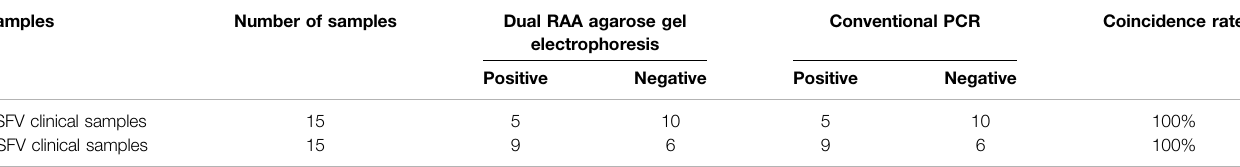
TABLE 6 | Comparison of Dual RAA agarose gel electrophoresis and conventional PCR in clinical samples.